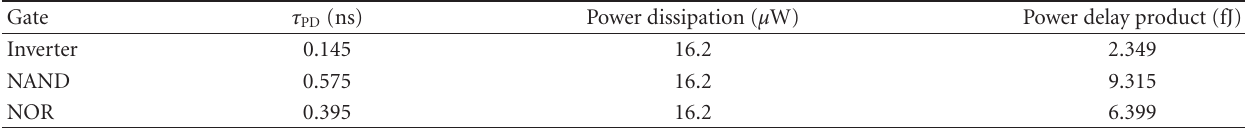
Table 2: PFSCL Tristate gates based on switch transistor technique.